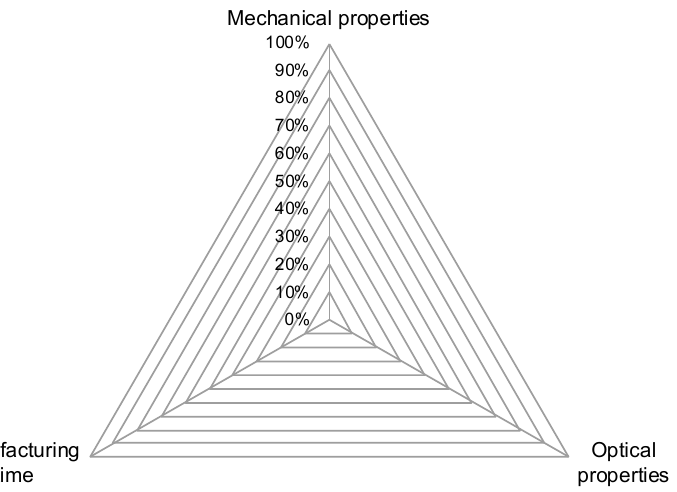
Figure 1. Triangle of goals for FDM, depicted as radial chart. Not all properties can be reached optimally at the same time.